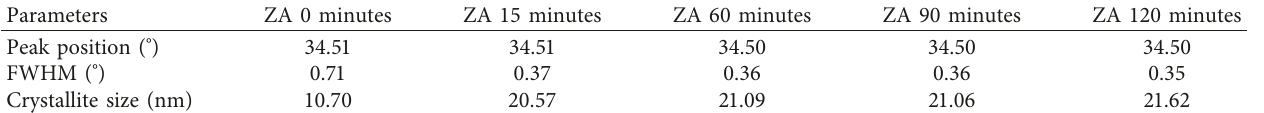
Figure 4: XRD profiles of the grown ZnO NRs from the ZA source with growth time t at 0, 15, 60, 90, and 120 minutes. Table 2: FWHM analysis of the (002) XRD peak in ZnO NRs grown from the ZA source.